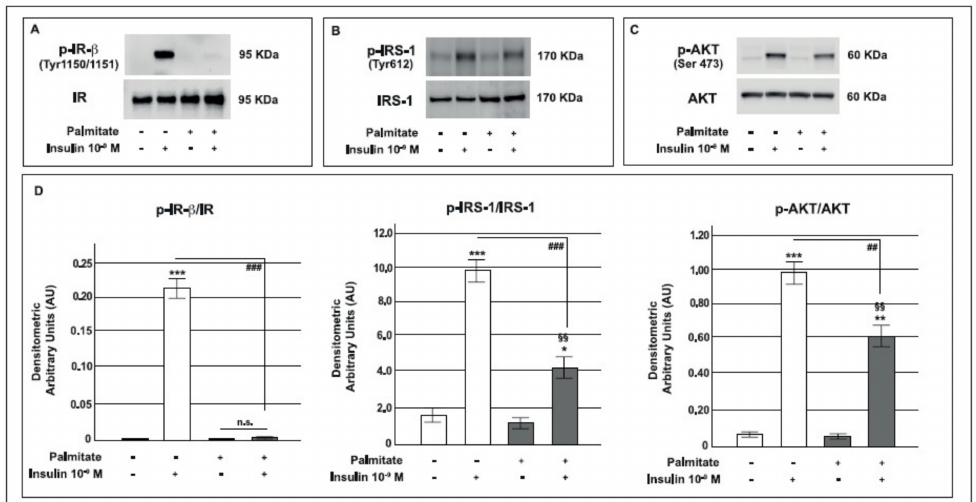
Figure 3. Effect of pre-exposure to palmitate on IR phosphorylation and the IRS-1/AKT pathway in GLUTag cells. Representative immunoblot from control and palmitate GLUTag treated cells (0.5 mM for 24 h) acutely stimulated with insulin 10 − 9 M for 5 min for: A : immunoprecipitation of the total IR (Tyr1150/1151 on the β subunit) (p-IR- β ) and total IR; B : p-IRS-1 (Tyr612) and total IRS-1 (IRS-1); C : p-AKT (Ser 473) and total AKT (AKT); D : corresponding densitometric analysis in control cells (open bars) and in cells exposed to palmitate (gray bars). * p < 0.05, ** p < 0.01, *** p < 0.001 vs. basal control; ## p < 0.01, ### p < 0.001 vs. insulin stimulated control group; §§ p < 0.01 vs. palmitate; n.s. not